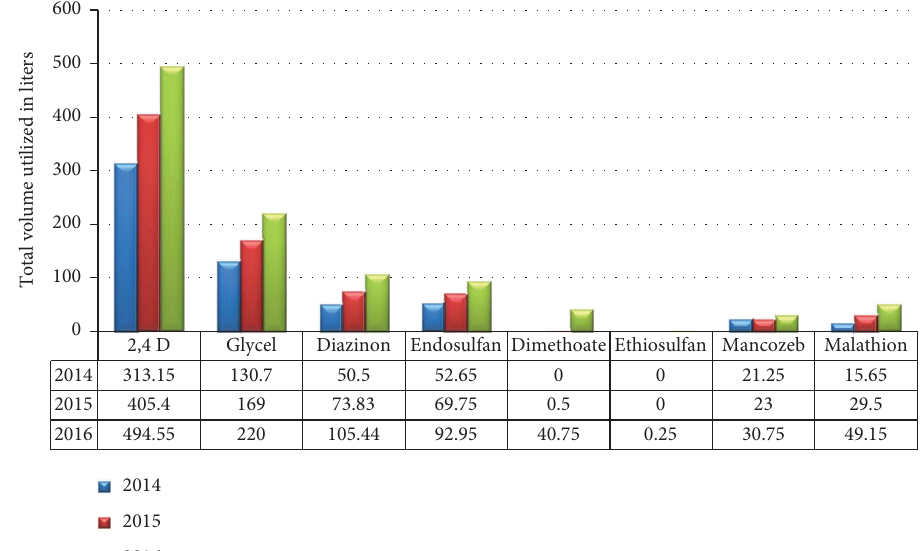
Figure 3: Te trend of pesticide utilization in liters from the year 2014 to 2016 in Chilga district.